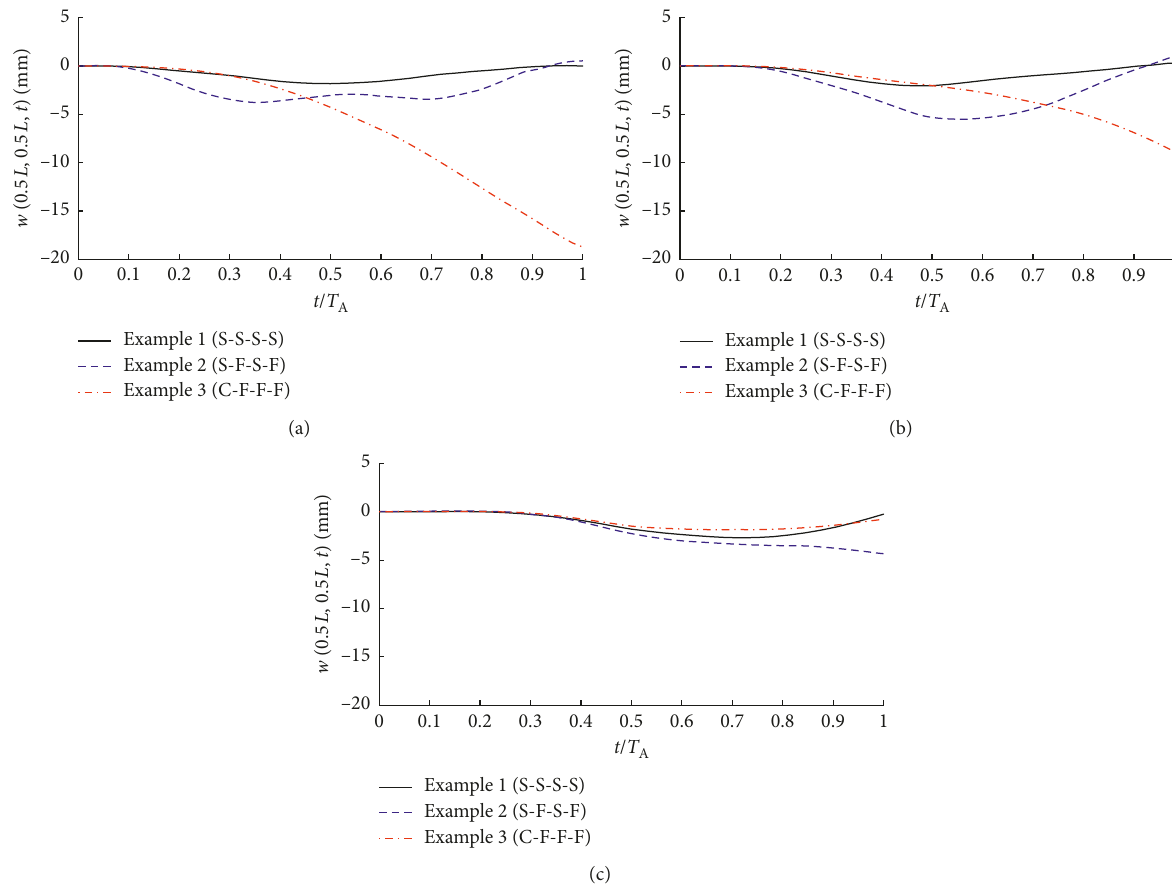
Figure 17: Effects of boundary conditions and moving speed v a moving point force travels along the trajectory given by Case 2 of (39). (a) v 0